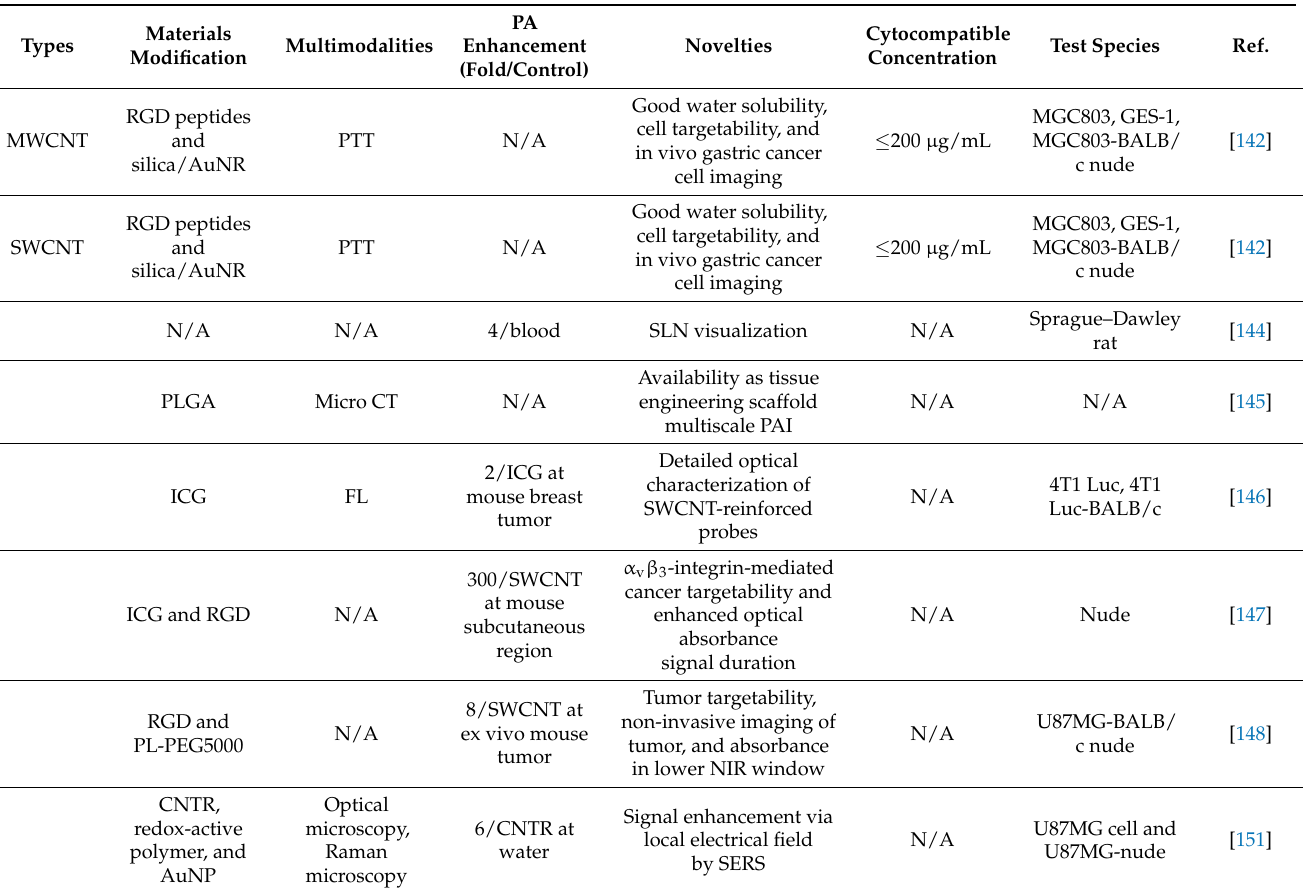
Table 3. CNT-based PAI. Each piece of research is classified by CNT types, modification, abbreviation, theragnosis multimodalities, PA signal enhancement, novelties, maximum cytotoxicity concentration, and test species. CNTR, carbon nanotube ring; LBL, layer-by-layer; CD, carbon dot; CND, carbon nanodot; CNS, carboneous nanosphere; Cur, curcumin; HA, hyaluronic acid; SLN, sentinel lymph node; PDDA, poly (diallyl dimethyl ammonium chloride); PLGA, poly(lactic-co-glycolic acid); PL- PEG5000, polyethylene glycol-5000 grafted phospholipid; PSS, poly (sodium 4-styrene sulfonate); RGD, cyclic